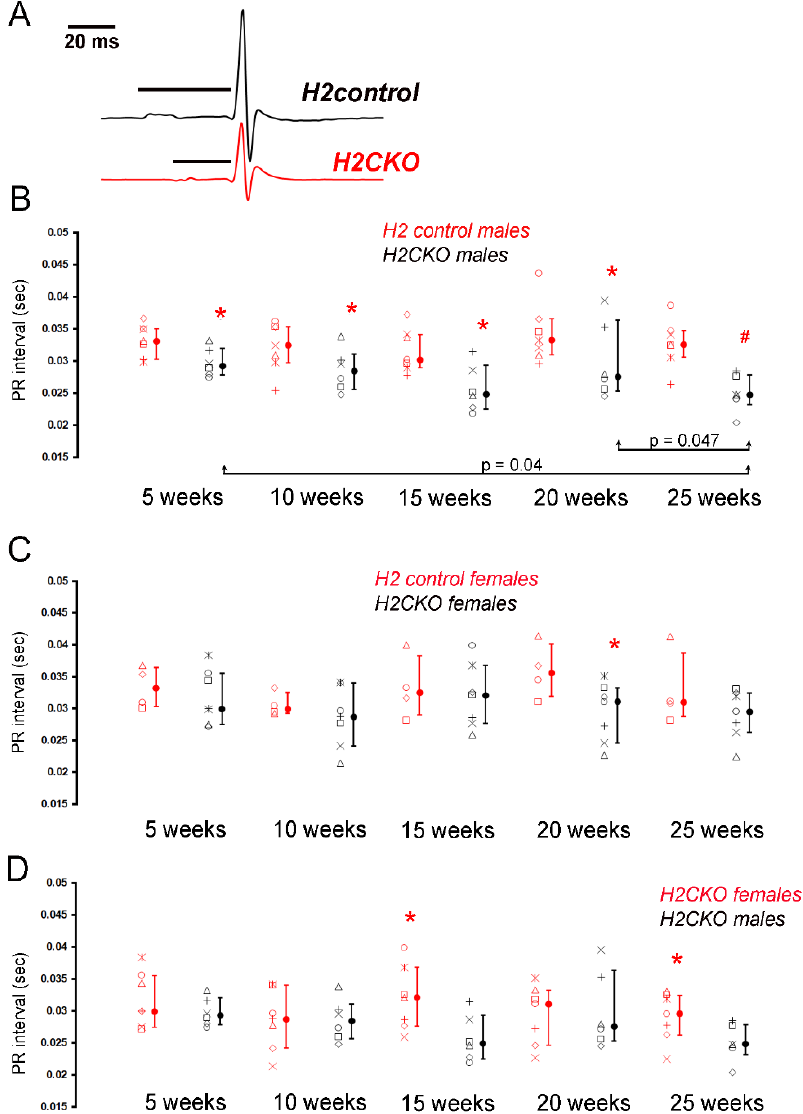
Figure 2. Loss of Hand2 in post-natal CCS results in sex-dependent effects on AV conduction. ( A ) Exemplary surface ECGs recorded from an anesthetized H2CKO male (red line) and male H2control littermate (black line) at 25 weeks of age. Horizontal black lines above traces denote lengths of PQ intervals. ( B ) PR intervals (in seconds) in Lead I ECG analysis from male Cntn2 Cre-EGFP/+ ; Hand2 fx/fx ( H2CKO s, open black symbols, n = 7) and Hand2 fx/fx ( H2control , open red symbols, n = 6) mice at 5-week, 10-week, 15-week, 20-week, and 25-week time points. Identical symbols on the left of each line in graph represent the values of the same individual mouse across time points. Filled circles, medians; error bars, 25th and 75th percentiles. * p < 0.05, # p < 0.01 versus male H2control . ( C ) PR intervals (in seconds) in Lead I ECG analysis from female Cntn2 Cre-EGFP/+ ; Hand2 fx/fx ( H2CKO s, open black symbols, n = 7) and Hand2 fx/fx ( H2control , open red symbols, n = 4) mice at 5-week, 10-week, 15-week, 20-week, and 25-week time points. Identical symbols on the left of each line in graph represent the values of the same individual mouse across time points. Filled circles, medians; error bars, 25th and 75th percentiles. * p < 0.05 versus female H2control . ( D ) PR intervals (in seconds) in Lead I from male (open black symbols) and female (open red symbols) H2CKO mice at 5-week, 10-week, 15-week, 20-week, and 25-week time points. Identical symbols on the left of each line in graph represent the values of the same individual mouse across time points. Filled circles, medians; error bars, 25th and 75th percentiles. * p < 0.05 versus female H2CKO.